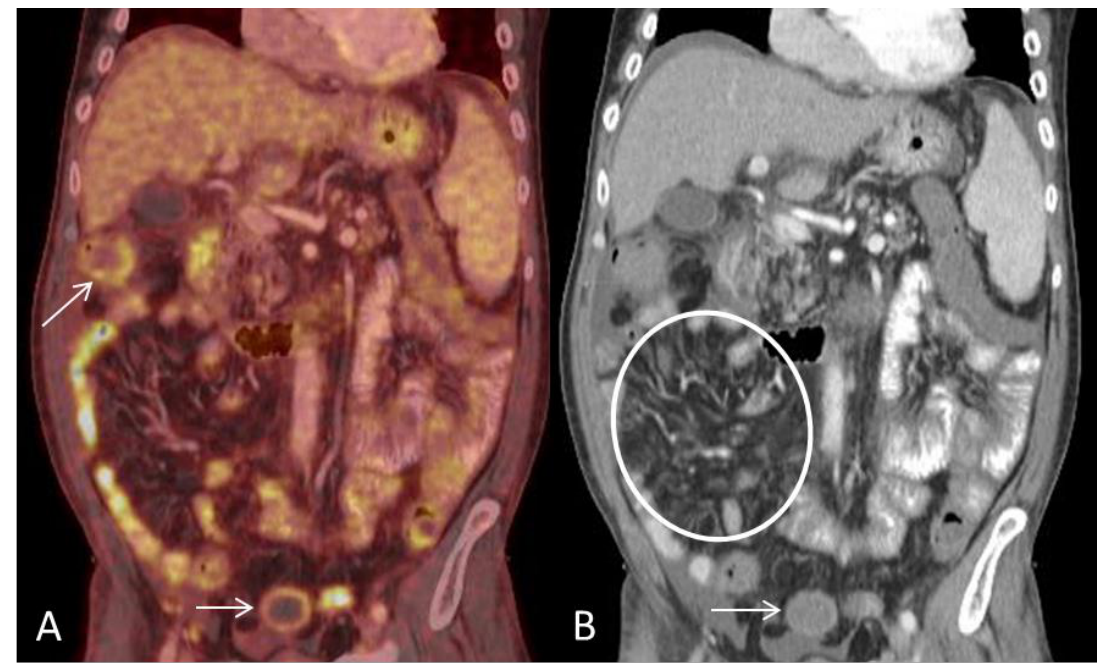
Figure 4. ( A ) Coronal PET and CT fused image demonstrates multifocal segmental pathological FDG-uptake in small-and large bowel loops. Circumferential mural pathological FDG-uptake in the large bowel (arrows). ( B ) Coronal CT shows engorgement of the vasa recta (circle) and mural enhancement of the large bowel (arrow). Ascites is present on the surface of the liver. Engorgement of the vasa recta is due to increased blood-flow in small arteries of inflamed bowel segments and has been reported as the most consistent extraintestinal finding in acute GIT-GVHD [2].